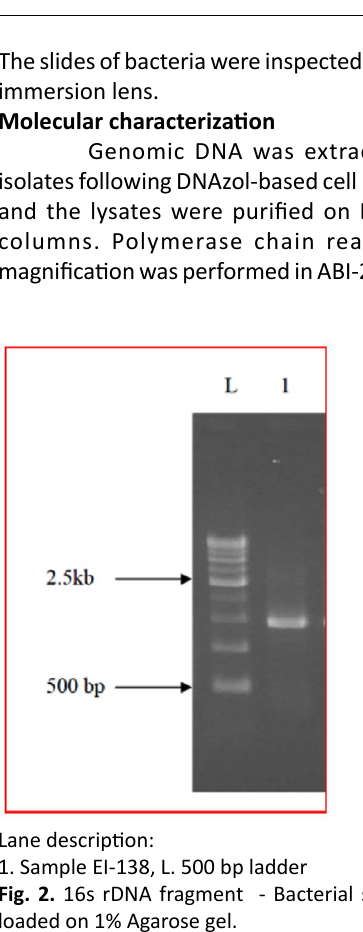
Fig. 2. 16s rDNA fragment - Bacterial sample EI-138 loaded on 1% Agarose gel.